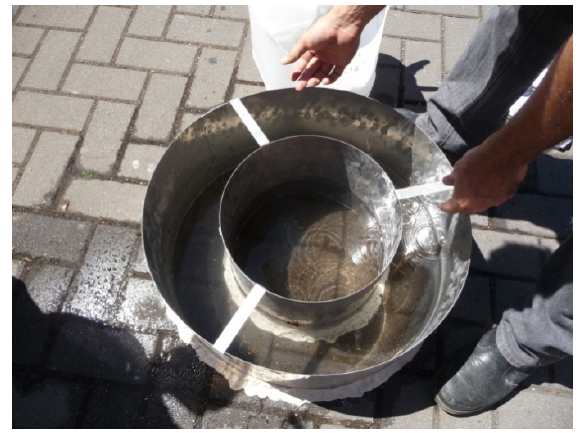
Figure 3. Double ring infiltration test on